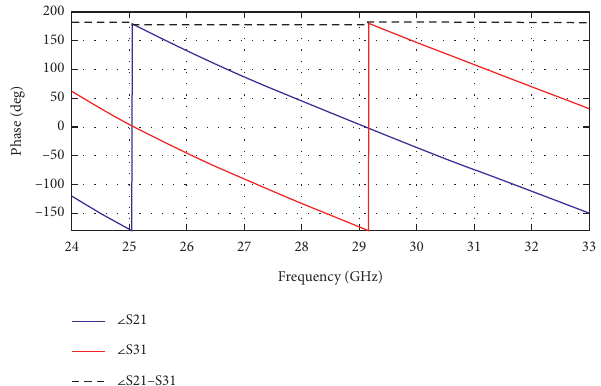
Figure 12: Simulated output phases of the E -probe transition between feed-1 and feed-2.